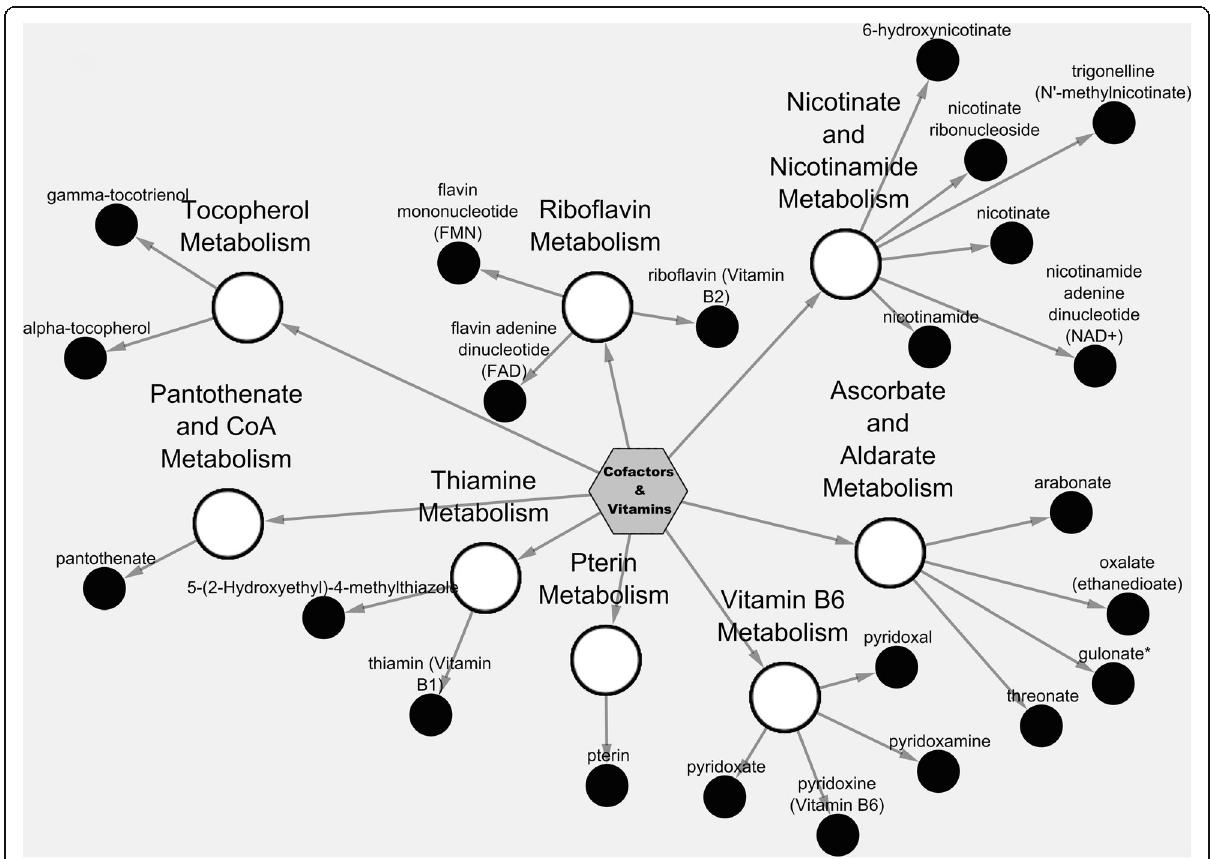
Fig. 2 Cytoscape network analysis of rice bran cofactor & vitamin metabolic pathways. Pathway specific network visualization is shown for Calrose rice bran. Each metabolite is represented as a node (circle), extending from a central sub-metabolic pathway node., The central hexagon node represents the super metabolic pathway. Node size corresponds to the Z-score using the relative abundance mean value for all three